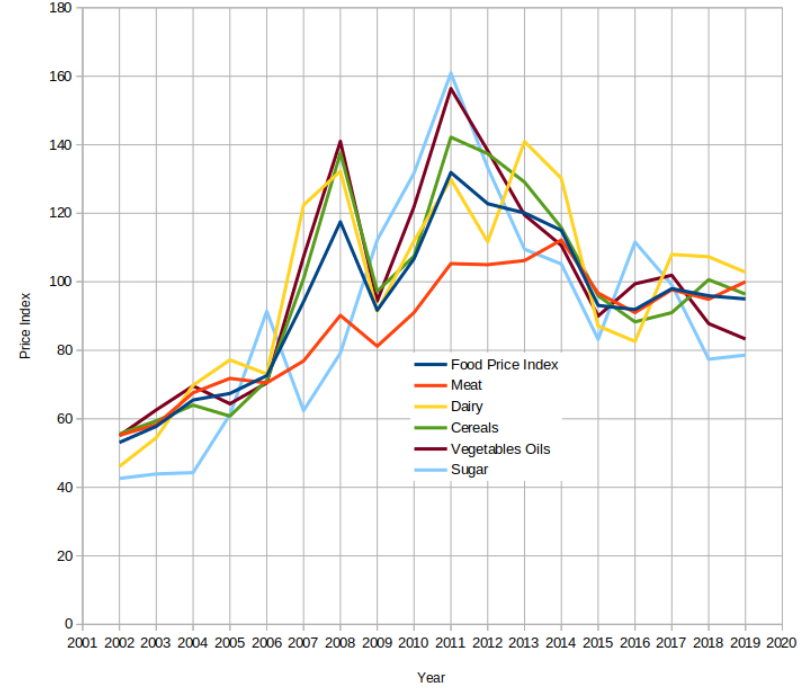
Figure 1. The price surge of food commodities during 2007–2008 and